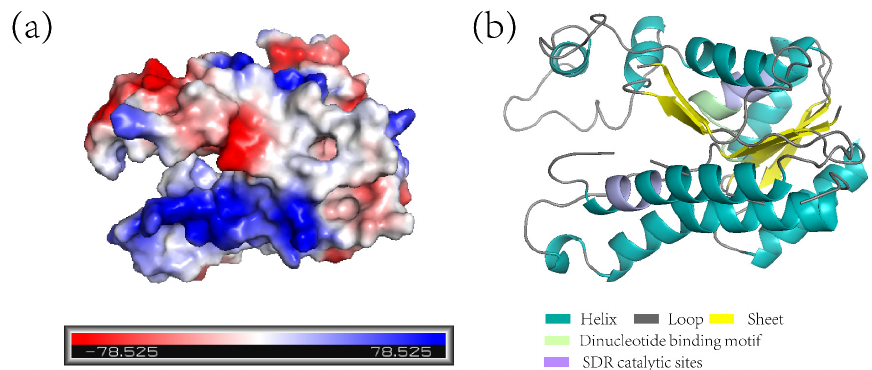
Figure 5. ZjNOL protein analysis. ( a ) The electrostatic potential distribution of ZjNOL protein. The value of electrostatic potential is positively associated with the depth of color, with blue representing positive potential and red representing negative potential. ( b ) Protein structure simulation of ZjNOL.